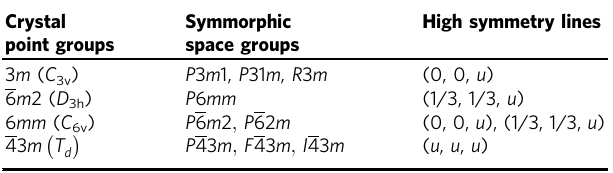
ThecorrespondingcrystalpointgroupsandhighsymmetrylinesatwhichBSVSPoccursarealso listed. Here, “ u ” characterizes the position of the k -point in the high symmetry line